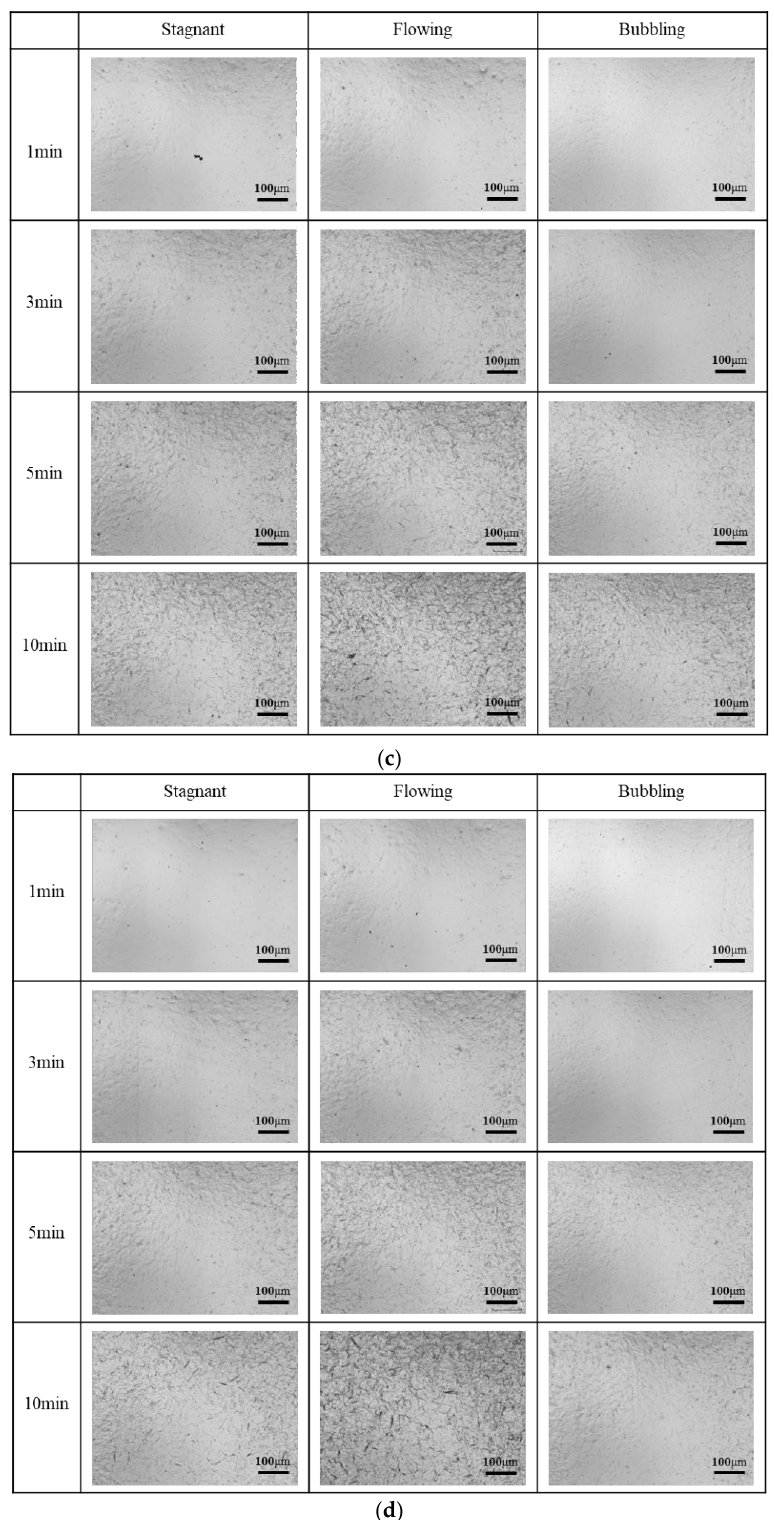
Figure 6. Surface damage at different points in experimental conditions of different flow states. ( a ) Surface damage at point 1 in different experimental conditions, ( b ) Surface damage at point 3 in different experimental conditions, ( c ) Surface damage at point 7 in different experimental conditions ( d ) Surface damage at point 10in different experimental